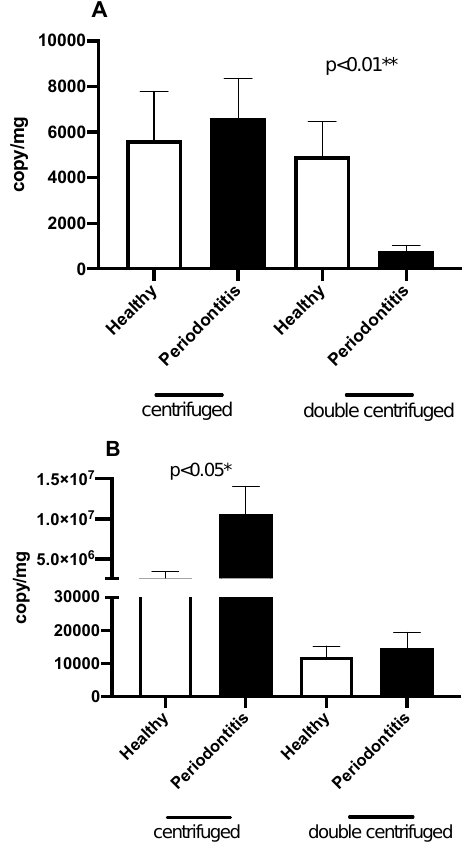
Figure 2. The e ff ect of periodontitis on A : nuclear DNA (ncDNA). No di ff erences were found in centrifuged samples. NcDNA was significantly lower in periodontitis in double-centrifuged samples ( p < 0.01**). The e ff ect of periodontitis on B : mitochondrial DNA (mtDNA). MtDNA was significantly higher in periodontitis in centrifuged samples. No di ff erences were found in double-centrifuged samples. Results are expressed as mean +